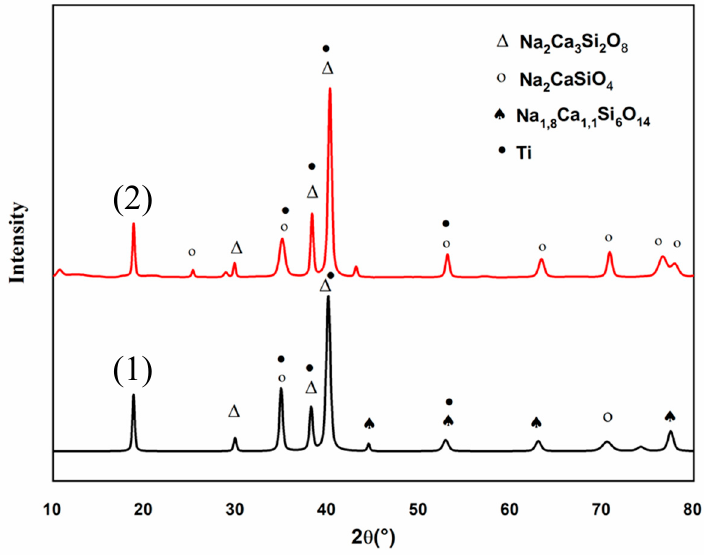
Figure 13. X-ray diffraction (XRD) pattern of C30 coating before (1) and after thermal treatment (2).